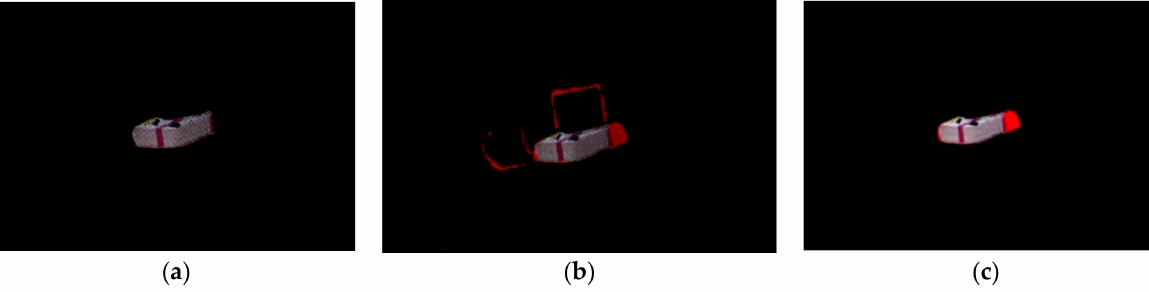
Figure 5. Illustration of classifying the edge region ( a ): original white box Mask R-CNN mask, ( b ): mask region and edge region, ( c ): edge region of the box is